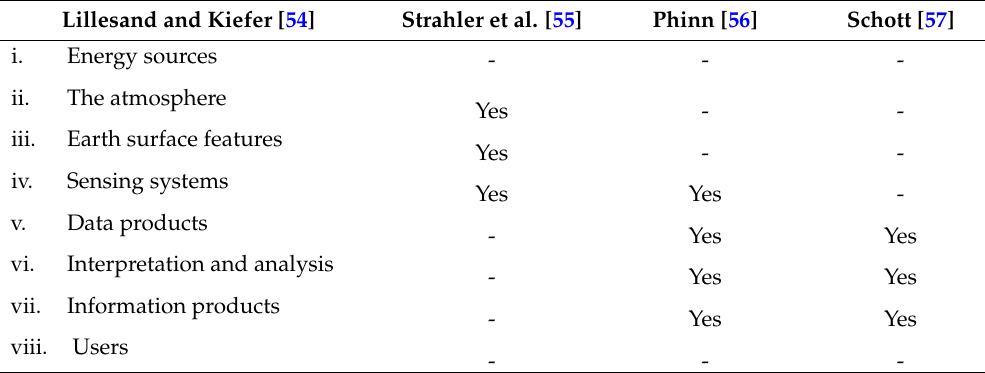
Table 4. Components of four conceptualizations of remote sensing